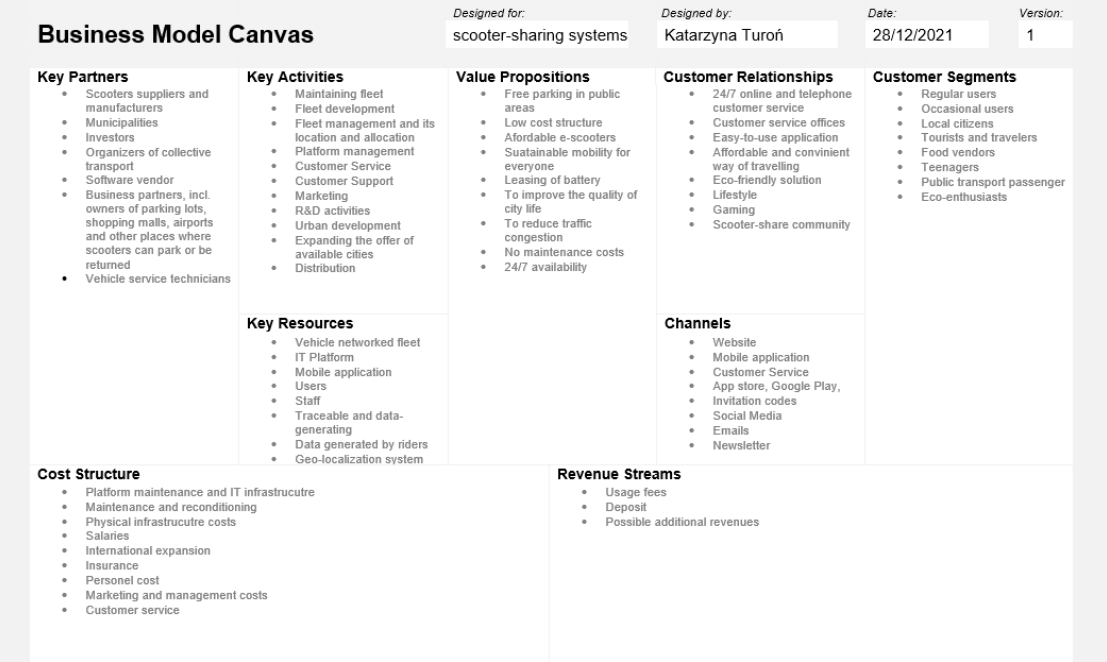
Figure 4. The scooter-sharing business model based on the CANVAS concept. Source: author’s own elaboration.